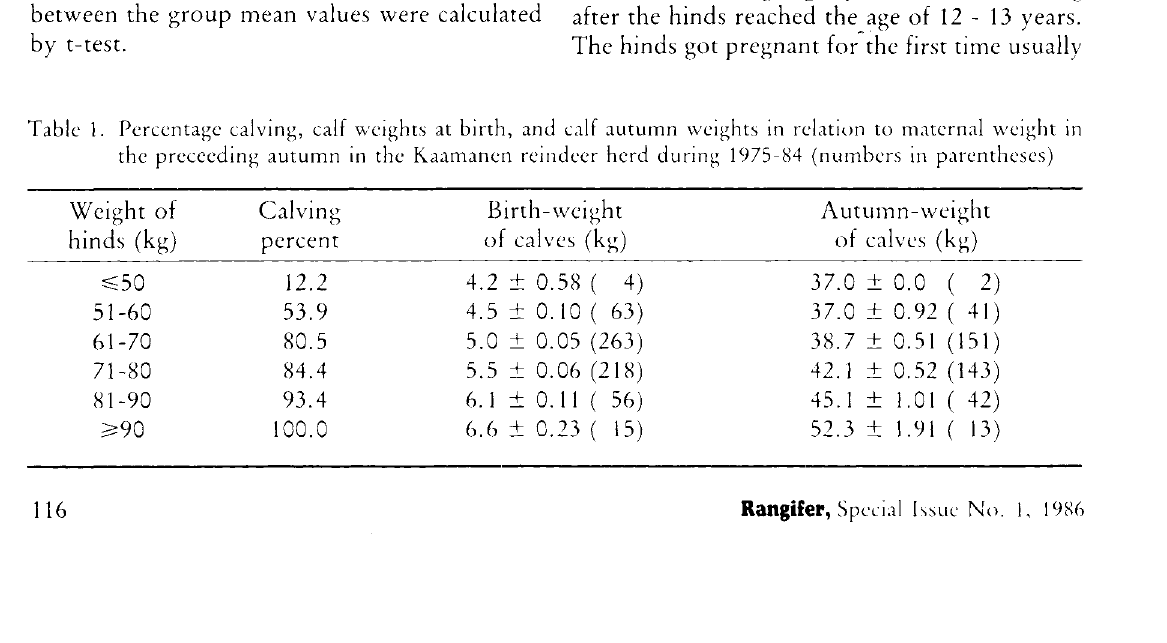
Table 1. Percentage calving, calf weights at birth, and calf autumn weights in relation to maternal weight in the preceed ing autumn in the Kaamanen reindeer herd during 1975-84 (numbers in parentheses) Weight of Calving Birth-weight Autumn-weight hinds